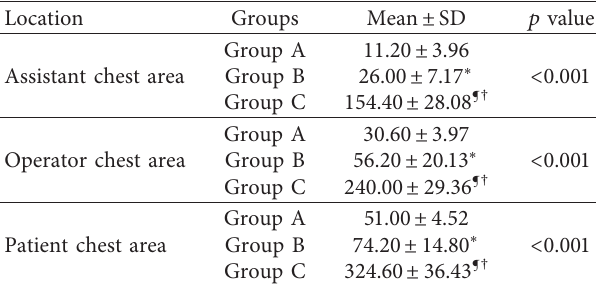
∗ NonsignificantbetweengroupsAandB; ¶ significantbetweengroupsBand C; † significant between groups A and